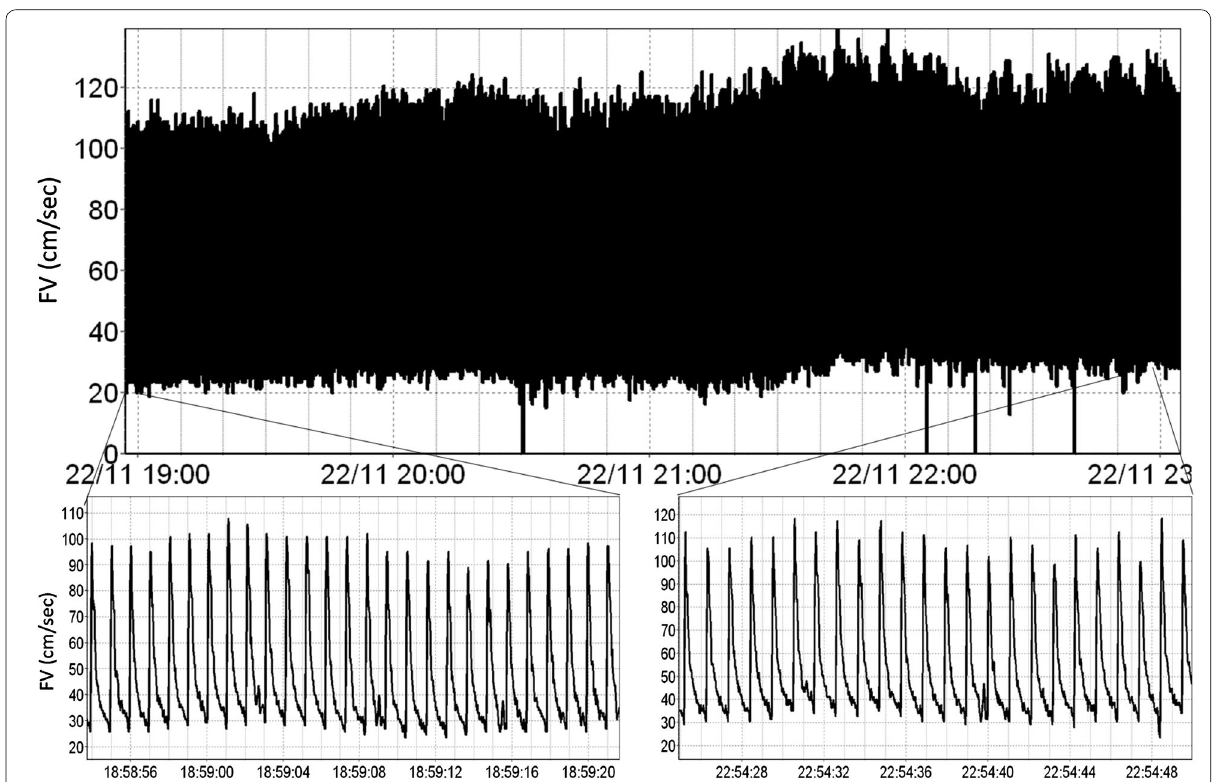
Fig. 3 TCD CBFV signal—Over 4 h recording session. CBFV cerebral blood flow velocity, cm centimeter, FV flow velocity, sec seconds, TCD transcranial Doppler. *Diagram depicts continuous uninterrupted FV signal over 4 waveforms from beginning (bottom left) and end (bottom right) of the recording, demonstrating preserved high-quality signal throughout the duration of the lengthy recording